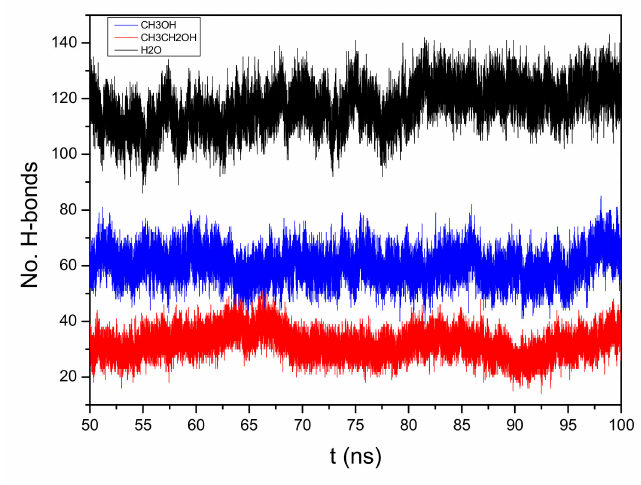
Figure 3. The number of H-bonds between cellulose chains in different 80 wt% anti-solvents in 293 K.